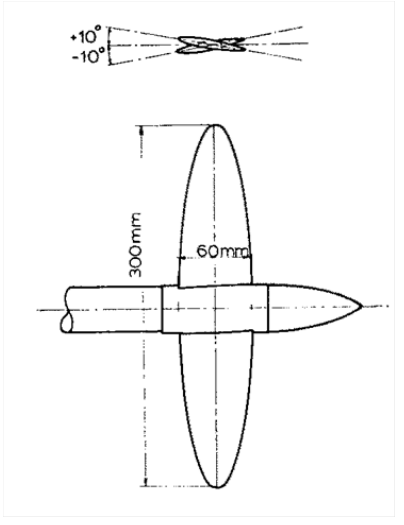
Figure 3. Schematic view of the cavitator. Table 1. Main geometrical features. The foil section type is NACA